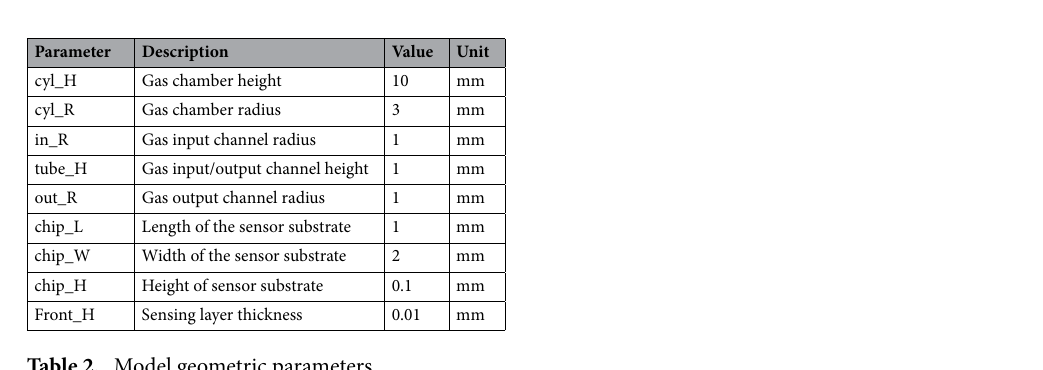
Table 2. Model geometric